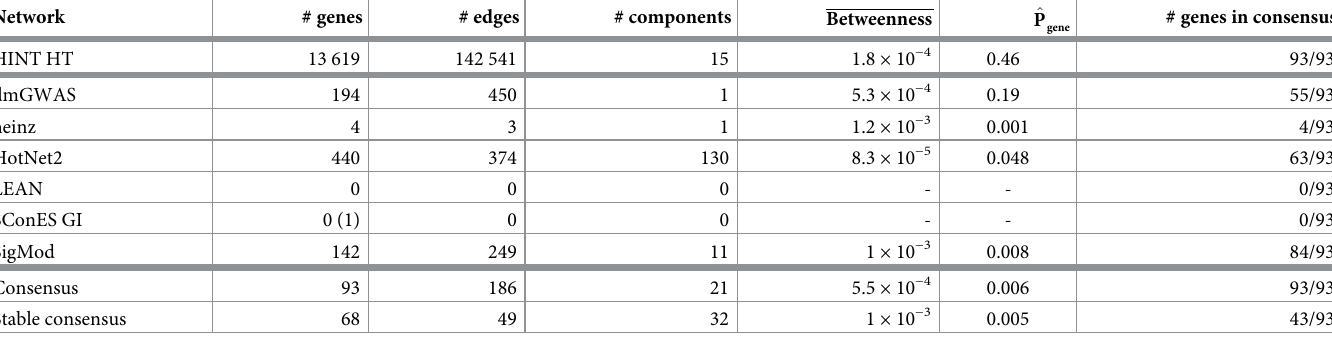
Table 2. Summary statistics on the solutions of multiple network methods on the PPIN. The first row contains the summary statistics on the whole PPIN.